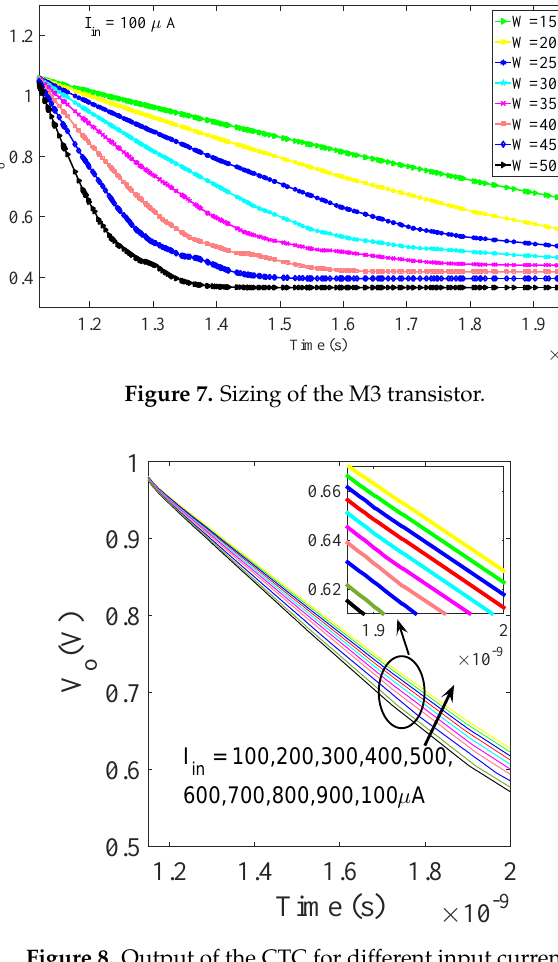
Figure 8. Output of the CTC for different input currents. Table 1. Caparison of the conversion gain with state-of-the-art